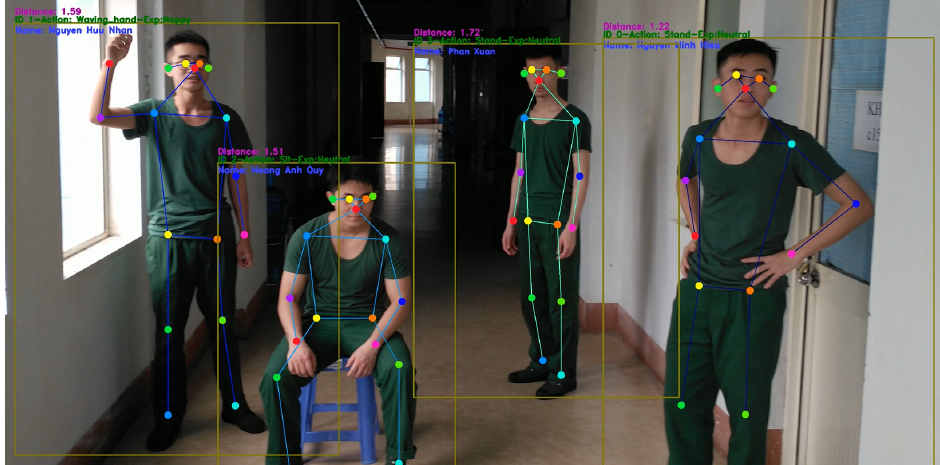
Figure 7. An example of the human keypoints extracted by the proposed method from a key frame of one the videos in the self-collected datasets. The proposed framework simultaneously performs action, face and emotion recognition on the selected key frame in real time. The human objects in this image have been labeled with their estimated distances, identified actions, emotions and identities through face recognition. For instance, from left to right, the identified actions and emotions for each human object are (waving hand, happy), (sitting, neutral), (standing, neutral), and (standing,